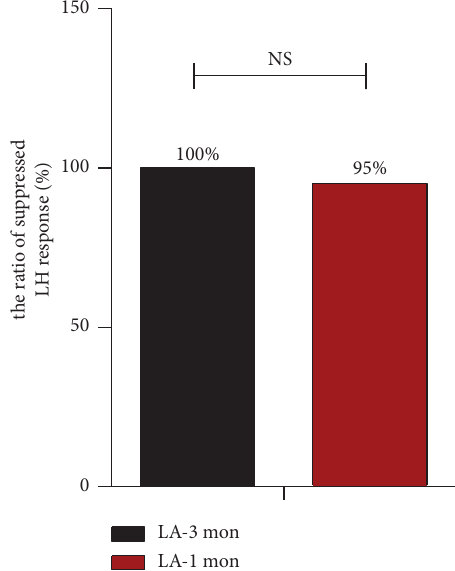
Figure 1: Suppressed LH response after treatment with LA 3- month and LA 1-month depots. Data are presented as number/total number (%). LH < 2.5IU/L indicates suppressed LH response. LA � Leuprorelin acetate, NS � No